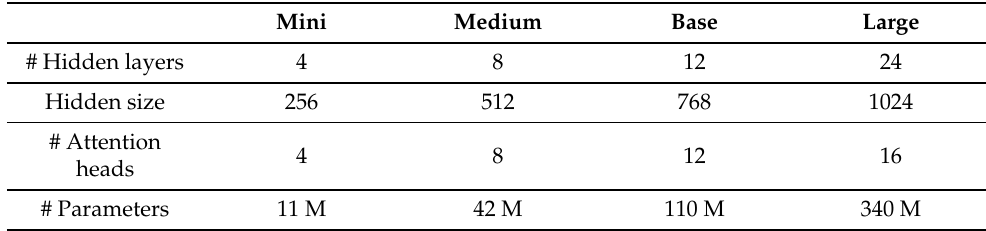
Figure 2. Architecture of the Arabic BERT-mini model. Table 1. The description of the large, base, medium, and mini-size Arabic BERT Models. Adapted with permission from Ref. [35]. 2023, Springer Nature Switzerland